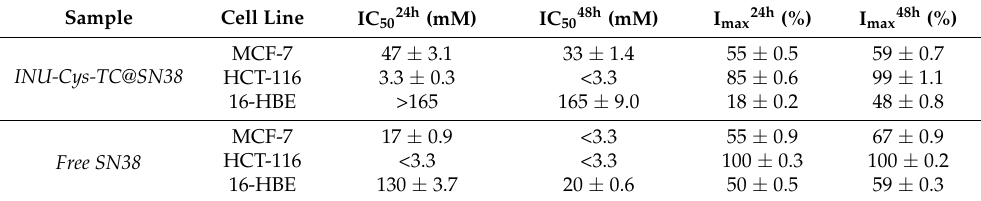
Table 3. Calculated half minimal inhibitory concentration (IC 50 ) and maximal inhibition (I max ) of INU-Cys-TC@SN38 and free SN38 after 24 and 24 h of incubation on MCF-7, HCT-116, and 16-HBE. Sample Cell Line